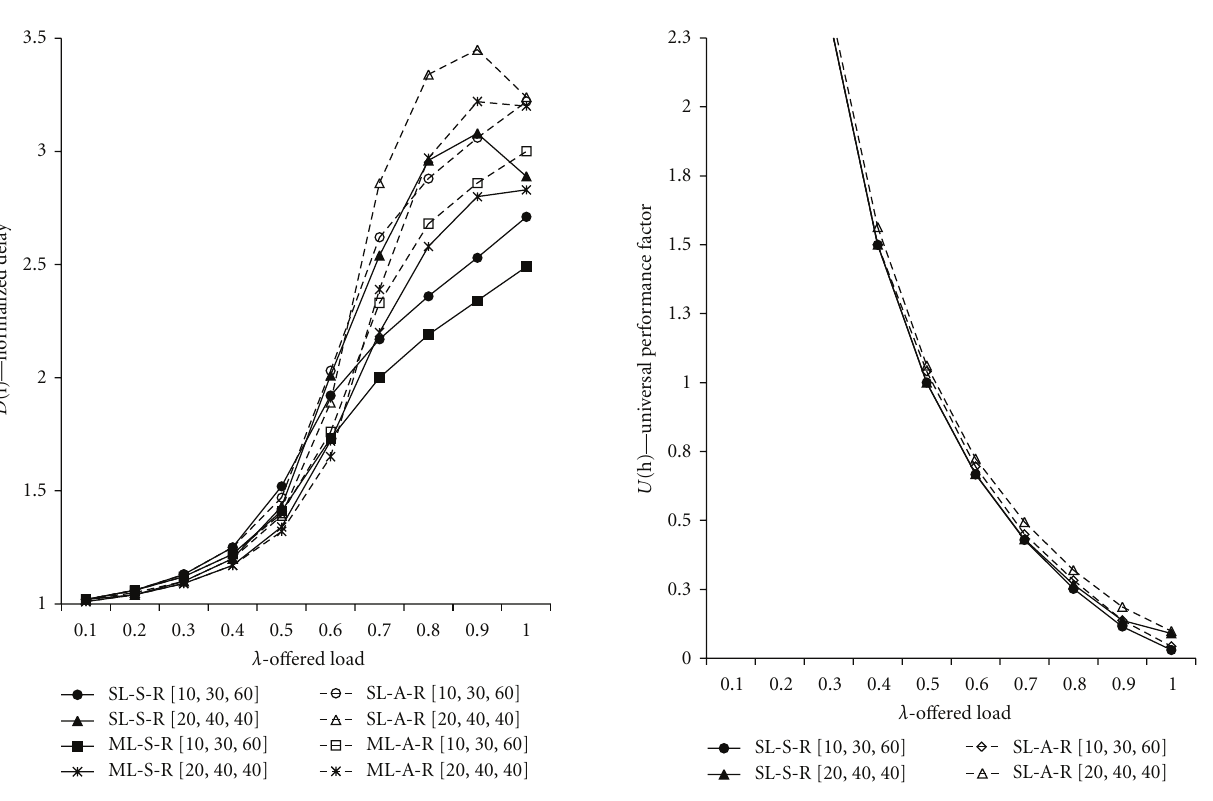
Figure 9: Universal performance factor of high-priority packets versus o ff ered